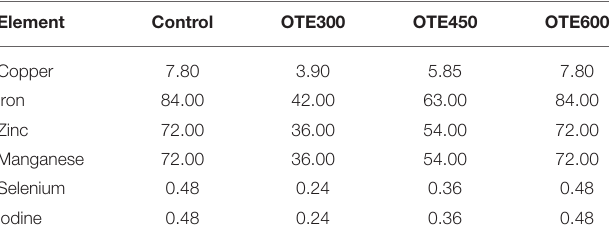
TABLE 2 | The forms and levels of trace elements in diets